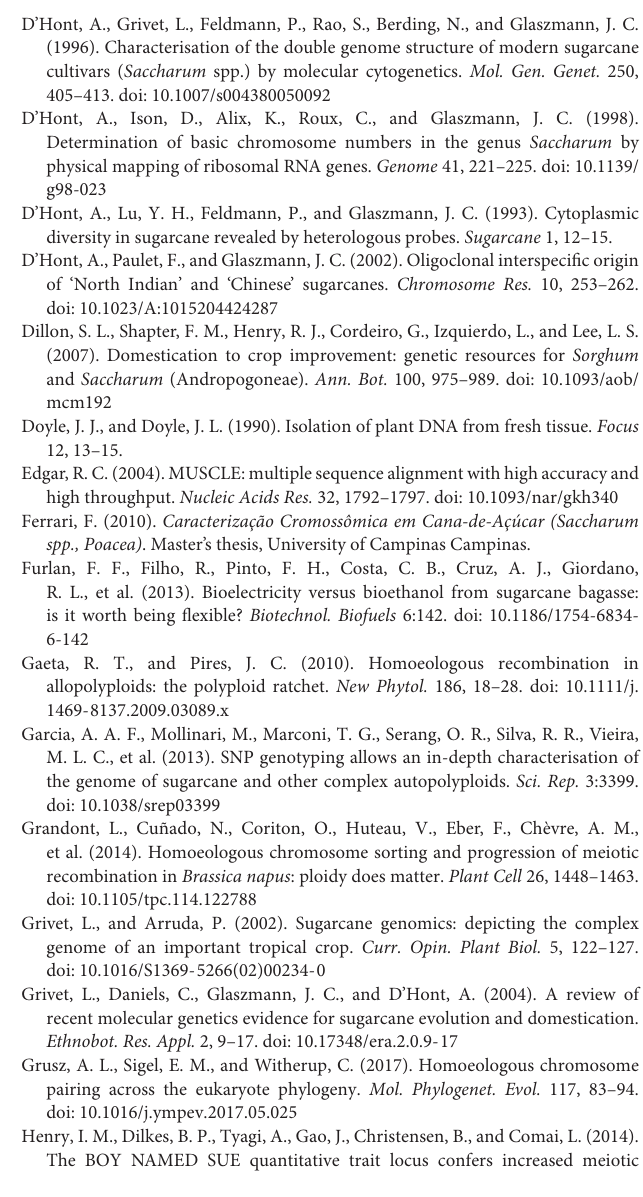
FIGURE S1 | (A) Agarose electrophoresis of PCR products amplified by the primer pair, CENT-F plus CENT-R. Genomic DNAs used as templates: “Caiana Fita” (lane 1) and IACSP93-3046 (lane 2); C, control reaction, without template DNA; M, 100 bp DNA ladder (Invitrogen). (B,C) Alignment of the centromeric consensus sequences of “Caiana Fita” (Repeat 1) and IACSP93-3046 (Repeat 2) against the SCEN repeat (Nagaki et al., 1998). FIGURE S2 | Anaphase cells showing a rod bivalent lagging chromosome ( A , arrowed) and chromosomal bridges (B)